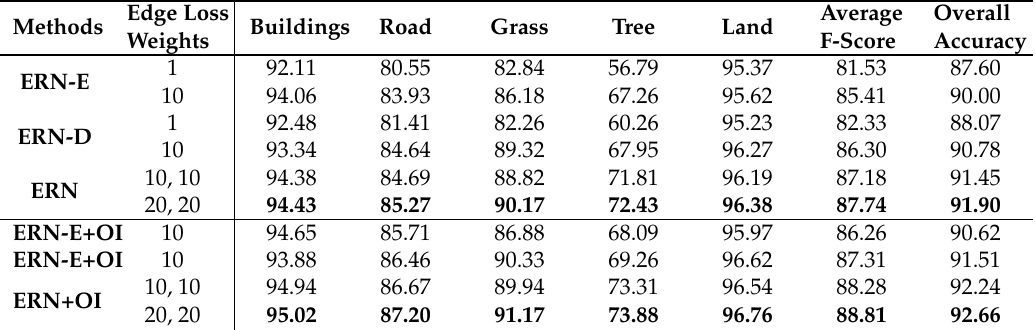
Table 7. Experimental results on the UAV Image Dataset. ERN-E is the encoder–decoder semantic segmentation net with only the encoder edge, while ERN-D is with only the decoder edge. OI: overlap inference. Edge Loss Methods